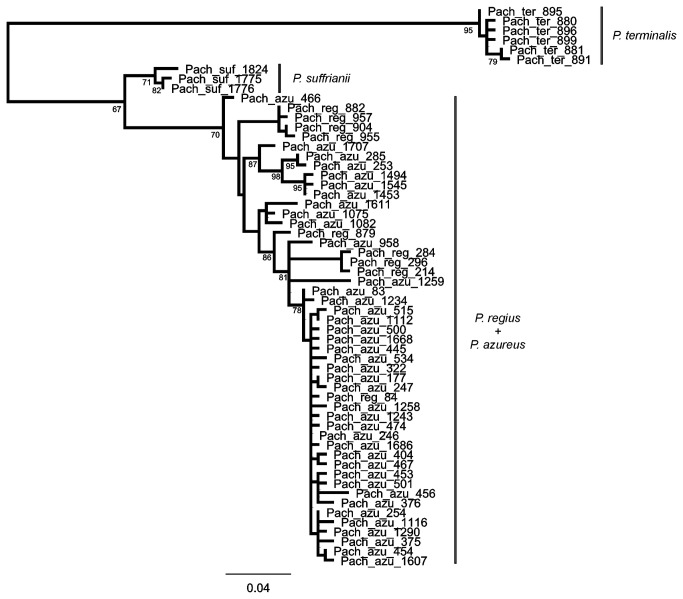
Maximum likelihood tree of cox1-5 ’ of 

Pachybrachis
 spp.Node values are bootstrap support values. That outgroup branch was removed to improve the visualization of the ingroup.